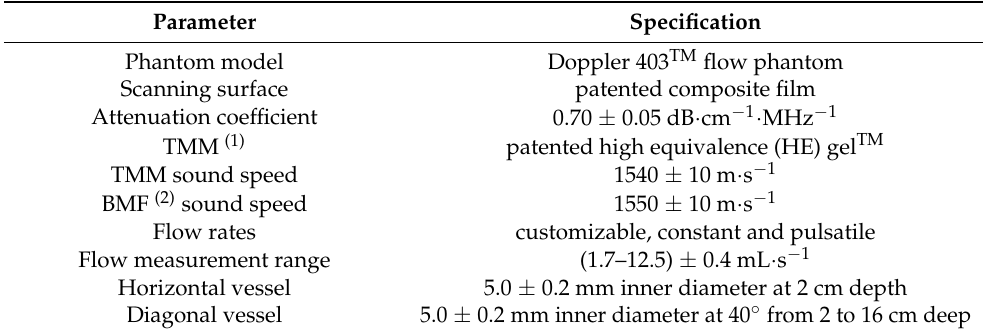
Table 1. Doppler flow phantom: technical